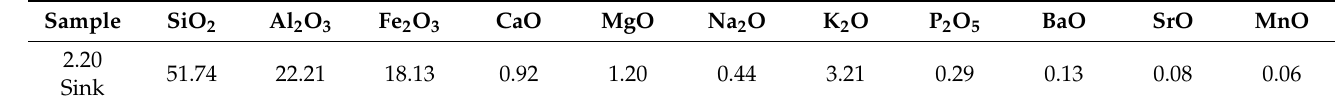
Figure 2. XRD analysis of the untreated 2.20 SG sink fraction of Baker seam coal ( -Kaolinite; -Quartz; -Pyrite). Table 2. XRF analysis of major and minor phases (wt.%) for the 2.20 sink fraction of the Baker seam coal.